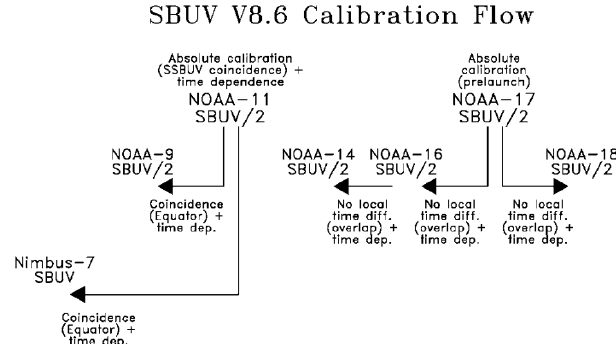
Fig. 11. Schematic diagram of calibration flow for SBUV instru- ments represented in V8.6 ozone product (except Nimbus-4 BUV).